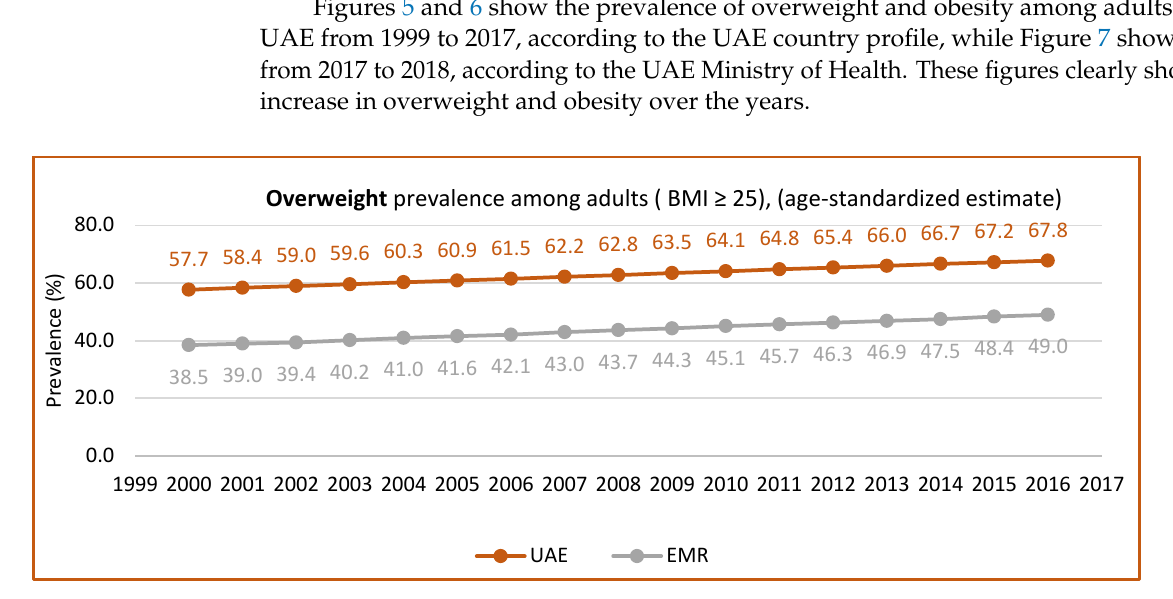
Figure 6. The prevalence of obesity in adults (BMI ≥ 30) (age-standardized estimate) UAE trend (1999 – 2017). Source: https://www.who.int/data/gho/data, http://www.healthdata.org/results/coun- try-profile (accessed on 5 December 2022) [33,35]. Figure 7. The prevalence of overweight and obesity (age-standardized estimate), 2017 – 2018 (the UAE). Source: https://www.mohap.gov.ae/Files/MOH_OpenData/1556/UAE_NHS_2018.pdf (ac- cesséd on 5 December 2022) [82].